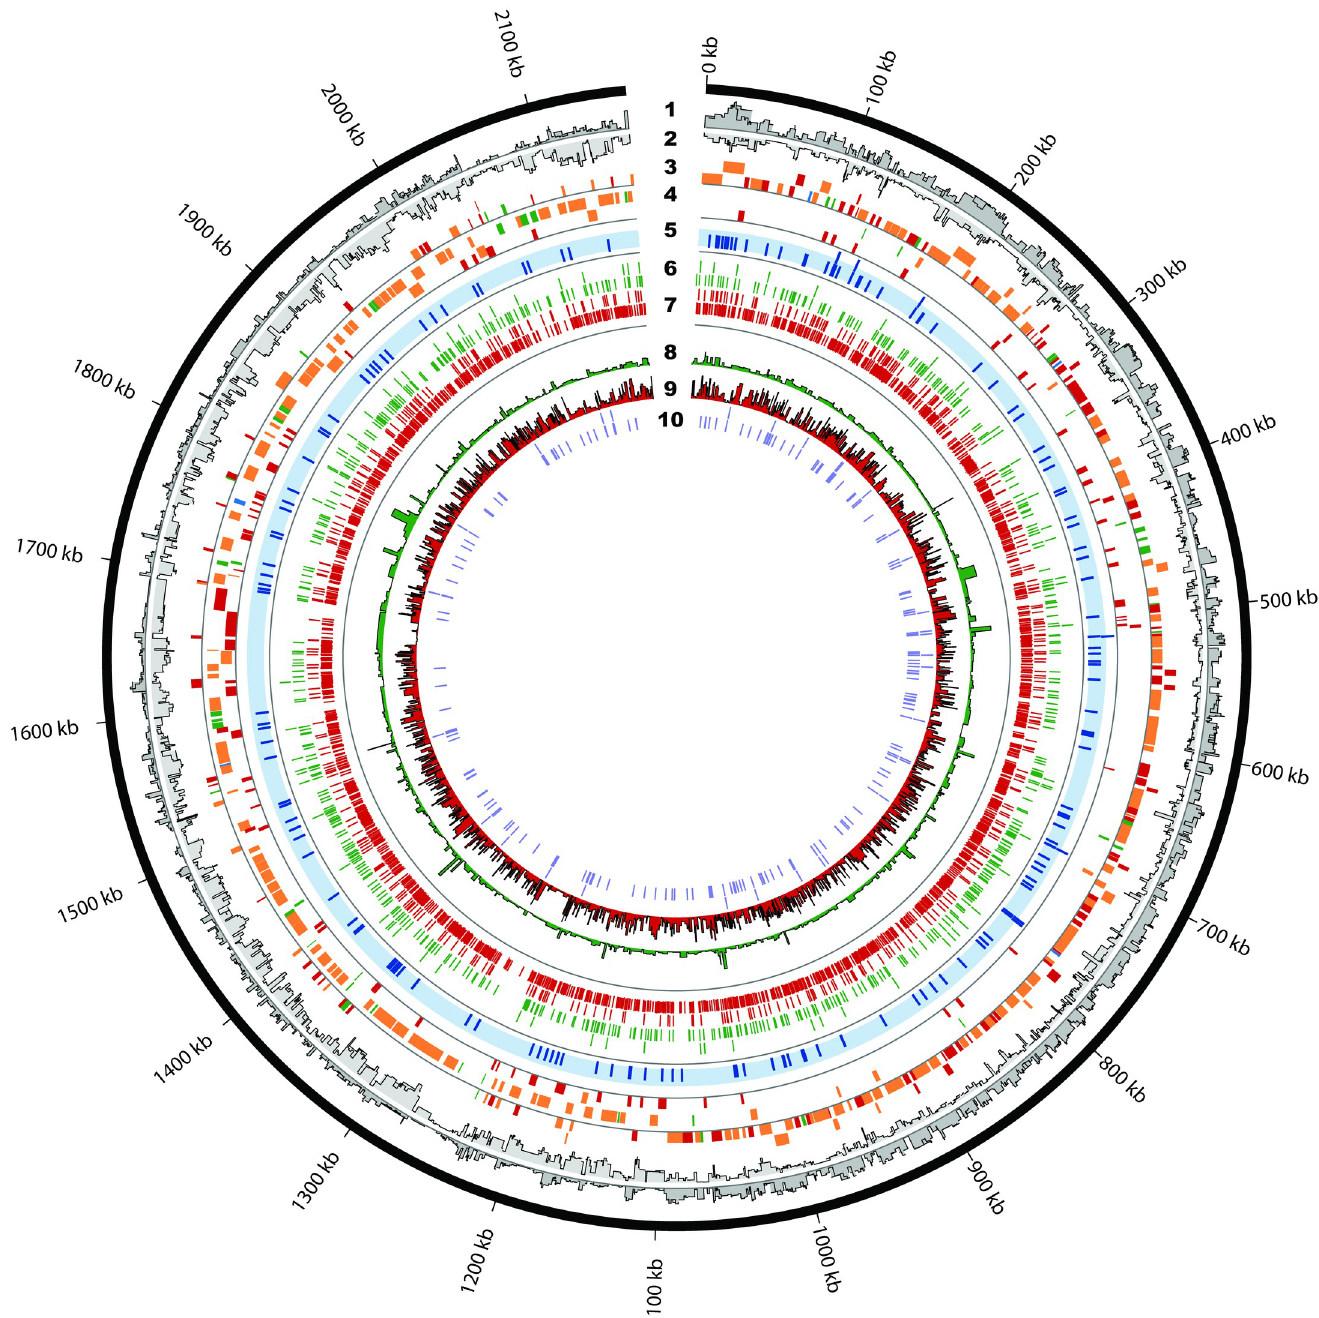
Fig 2. Genome-wide map of the Streptococcus pneumoniae TIGR4 transcriptional landscape. A map of all the transcriptional features identified. 1 . Paired-end RNA-Seq coverage of the plus strand. 2 . Paired-end RNA-Seq coverage of the minus strand. 3 . Annotated operon structures on the plus strand. Tile colors represent classification of the operons according to their number of high confidence TSS and TTSs: 1) traditional operons consisting of multiple genes with a single TSS and a TTS (green); 2) multiTSS operons consisting of multiple genes with internal TSSs but one TTS (blue); 3) multiTTS operons consisting of multiple genes with a single TSS but multiple internal TTSs (red); and 4) complex operons consisting of multiple genes with multiple internal TSSs and TTSs (orange). To avoid clutter, simple operons consisting of a single gene with a single TTS and TSS are omitted. 4 . Annotated operon structures on the minus strand. 5 . 141 novel putative intergenic regulatory elements in blue. 6 . 742 high confidence transcriptional start sites (TSS) in green. 7 . 1864 enriched transcriptional termination sites (TTS) in red. 8 . Log transformed processed/unprocessed ratio of each high confidence TSS. 9 . Log transformed coverage of each predicted TTS. 10 . Positions of the known structured non-coding RNAs and small RNAs. Figure was generated using Circos [79].